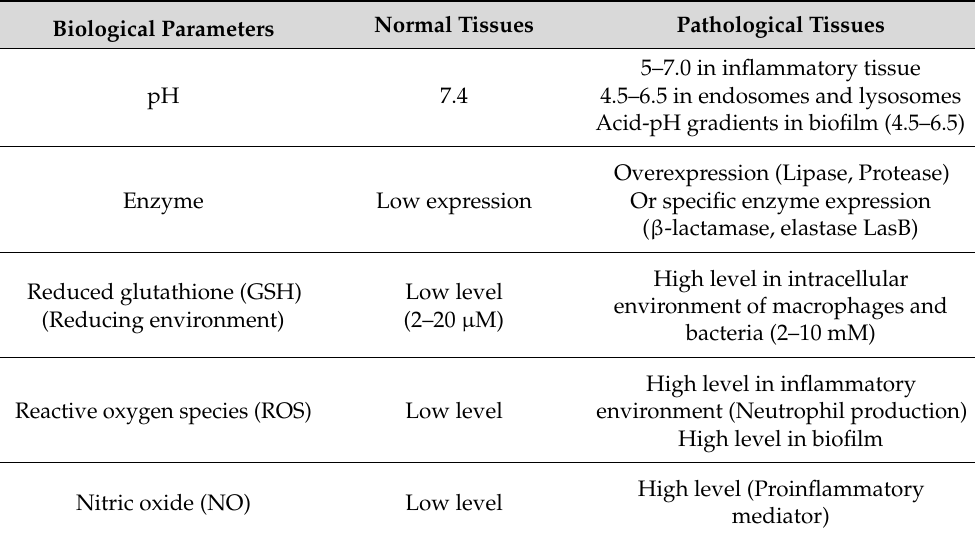
Table 1. Differences in physiological parameters between normal and pathological